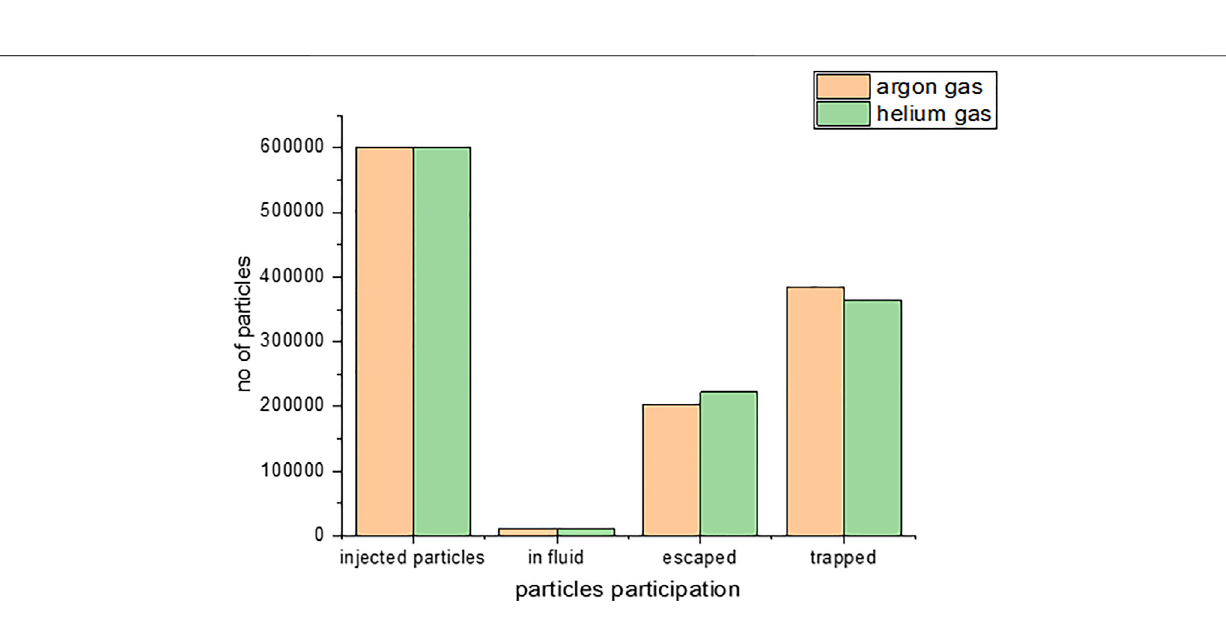
Width of powder distribution at focal point (mm)